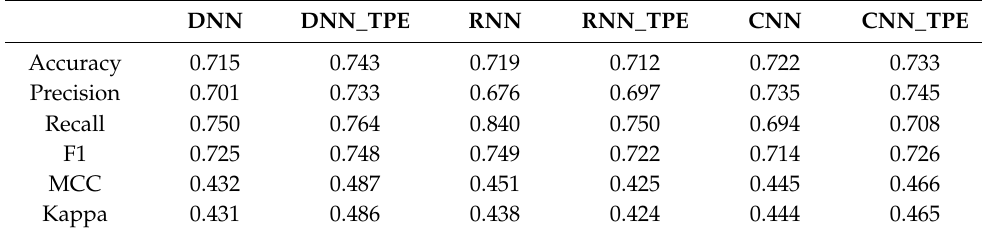
Table 5. Model validation results using multiple